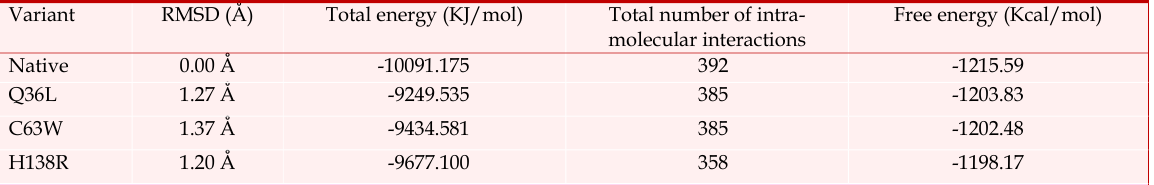
RMSD, t otal energy, number of intramolecular interactions and free energy for the native protein and